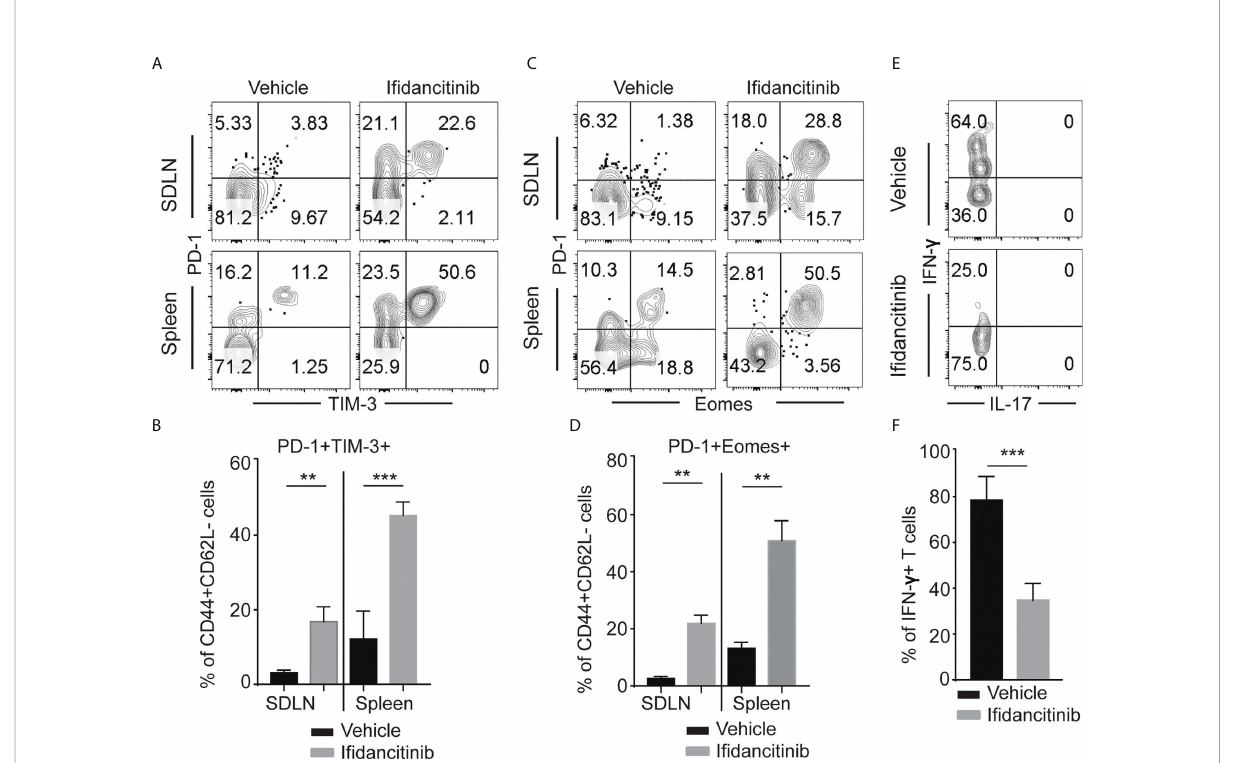
FIGURE 4 I fi dancitinib induced multiple co-inhibitory receptors in CD44 + CD62L - CD8 + T cells. Mice were treated as in Figure 3. (A) and (B) The frequency of PD-1 + , Tim-3 + and Eomes + T cells within CD44 + CD62L - CD8 + T cells populations within the SDLNs of mice treated with I fi dancitinib or vehicle. **P < 0.01, ***P < 0.001. (Unpaired Student t test). (C) and (D) The frequency of PD-1 + , Tim-3 + and Eomes + T cells within CD44 + CD62L - CD8 + T cells populations within spleen of mice treated with I fi dancitinib or vehicle. **P < 0.01. (Unpaired Student t test). (E) and (F) The frequency of IFN- g producing cells within CD44 + PD-1 + Tim-3 + CD8 + T cells from I fi dancitinib-treated mice or vehicle treated mice. ***P < 0.001. (Unpaired Student t